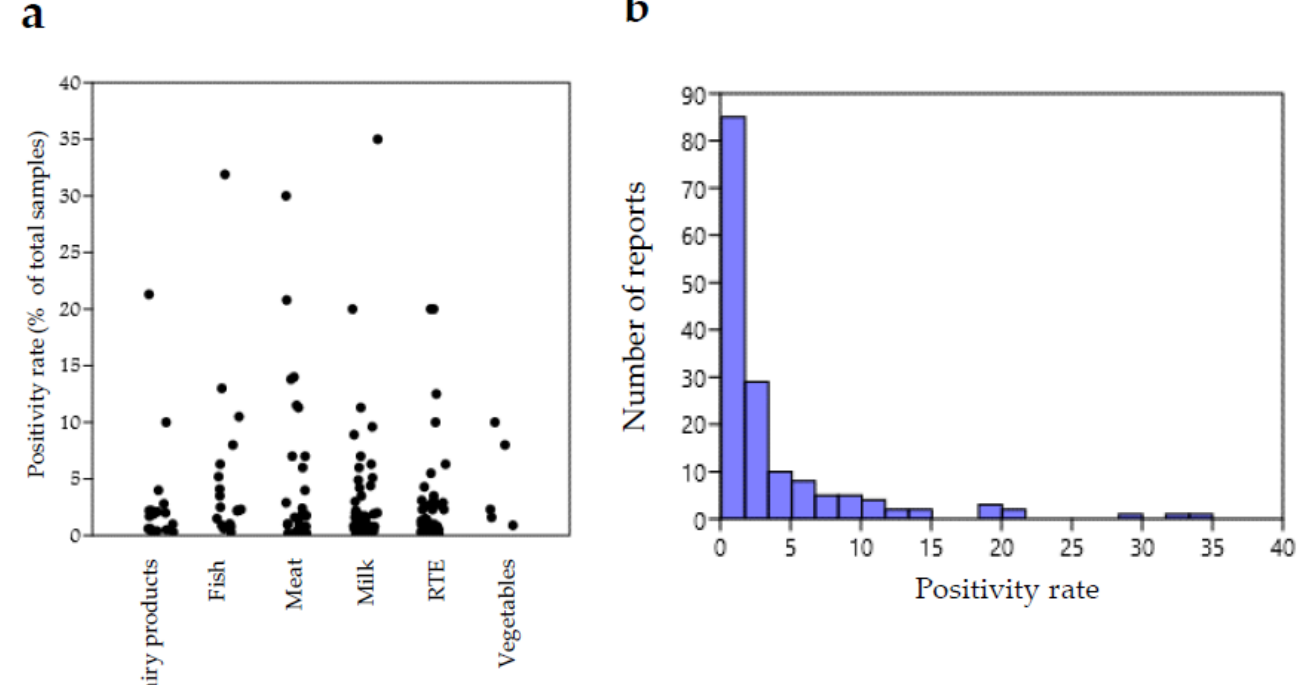
Figure 1. ( a ) Jitter plot representation of the distribution of reports summarized in Table 1 according to positivity rate (percentages of positive samples on total number of analyzed samples) per food category. Each circle corresponds to a report. ( b ) Histogram showing the number of reports falling in different intervals of L. ivanovii positivity rate for all food categories (B). Plots were obtained with the Past Statistical software 4.03 downloadable at https://past.en.lo4d.com/windows, accessed on 15 July 2022 [155].